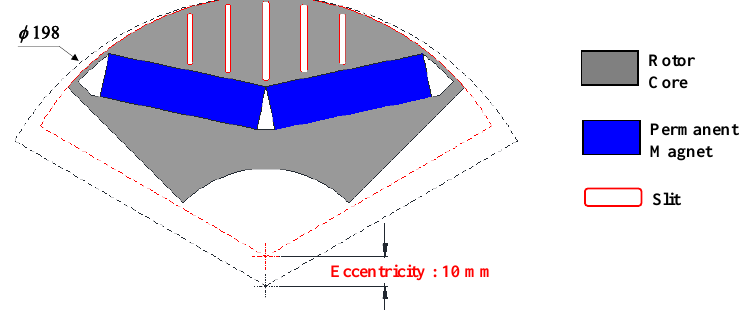
Figure 11. Cross-sectional view of the initial design. Table 4. Phase fundamental component and THD for the proposed models with an eccentricity of 10 mm. Model